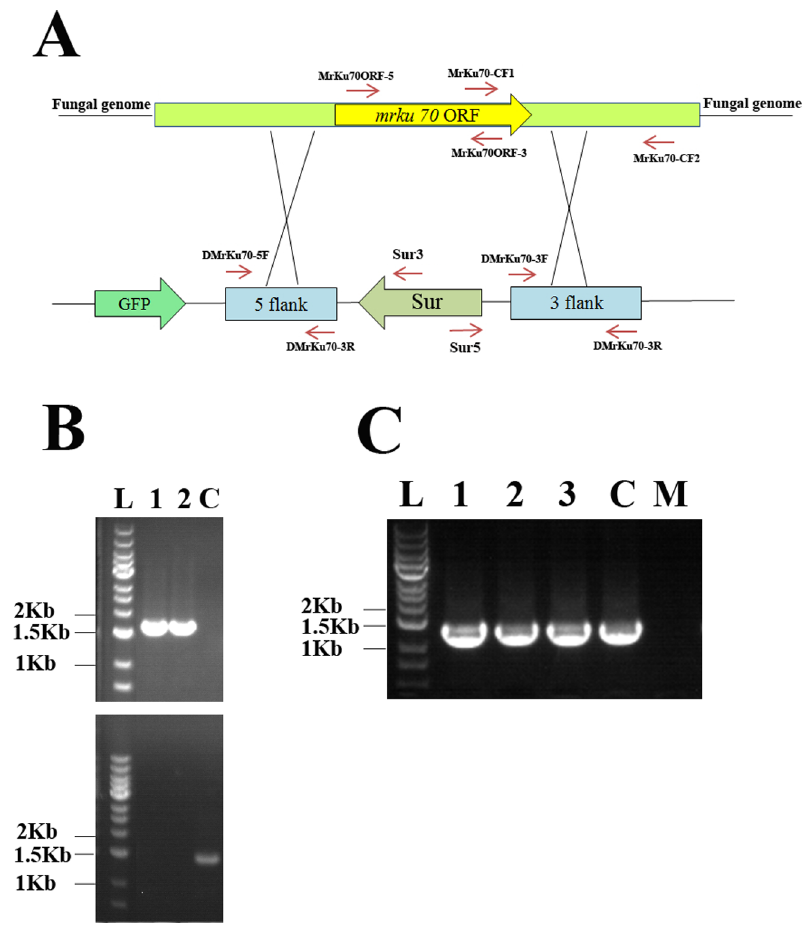
Figure 2. The disruption of MrKu70 in M.robertsii using the herbicide-resistance gene Sur as the selection marker. ( A ) The disruption plasmid of MrKu70 (bottom) and the relative position of MrKu70 in the wild-type strain. ( B ) Confirmation of the disruption of MrKu70 by PCR in the mutants with glufosinate ammonium resistance and without a GFP signal. 1 and 2 designate two different D MrKu70 mutants, and C is the wild-type strain. Top panel: PCR conducted with the primers Sur5 and MrKu70CF2, PCR products can be obtained only from MrKu70 disruption mutants; Bottom panel: PCR conducted using primers MrKu70CF1 and MrKu70CF2, and PCR products can be obtained in any strains other than MrKu70 disruption mutants. ( C ) Confirmation of the complementation of D MrKu70 by PCR using the primers MrKu70ORF-5 and MrKu70ORF-3 to amplify across the deleted region. 1 to 3: 3 different transformants with D MrKu70 complemented; C: the wild-type strain; M: D MrKu70 ; L: DNA ladder (DL 10004) from Generay (Shanghai, China).